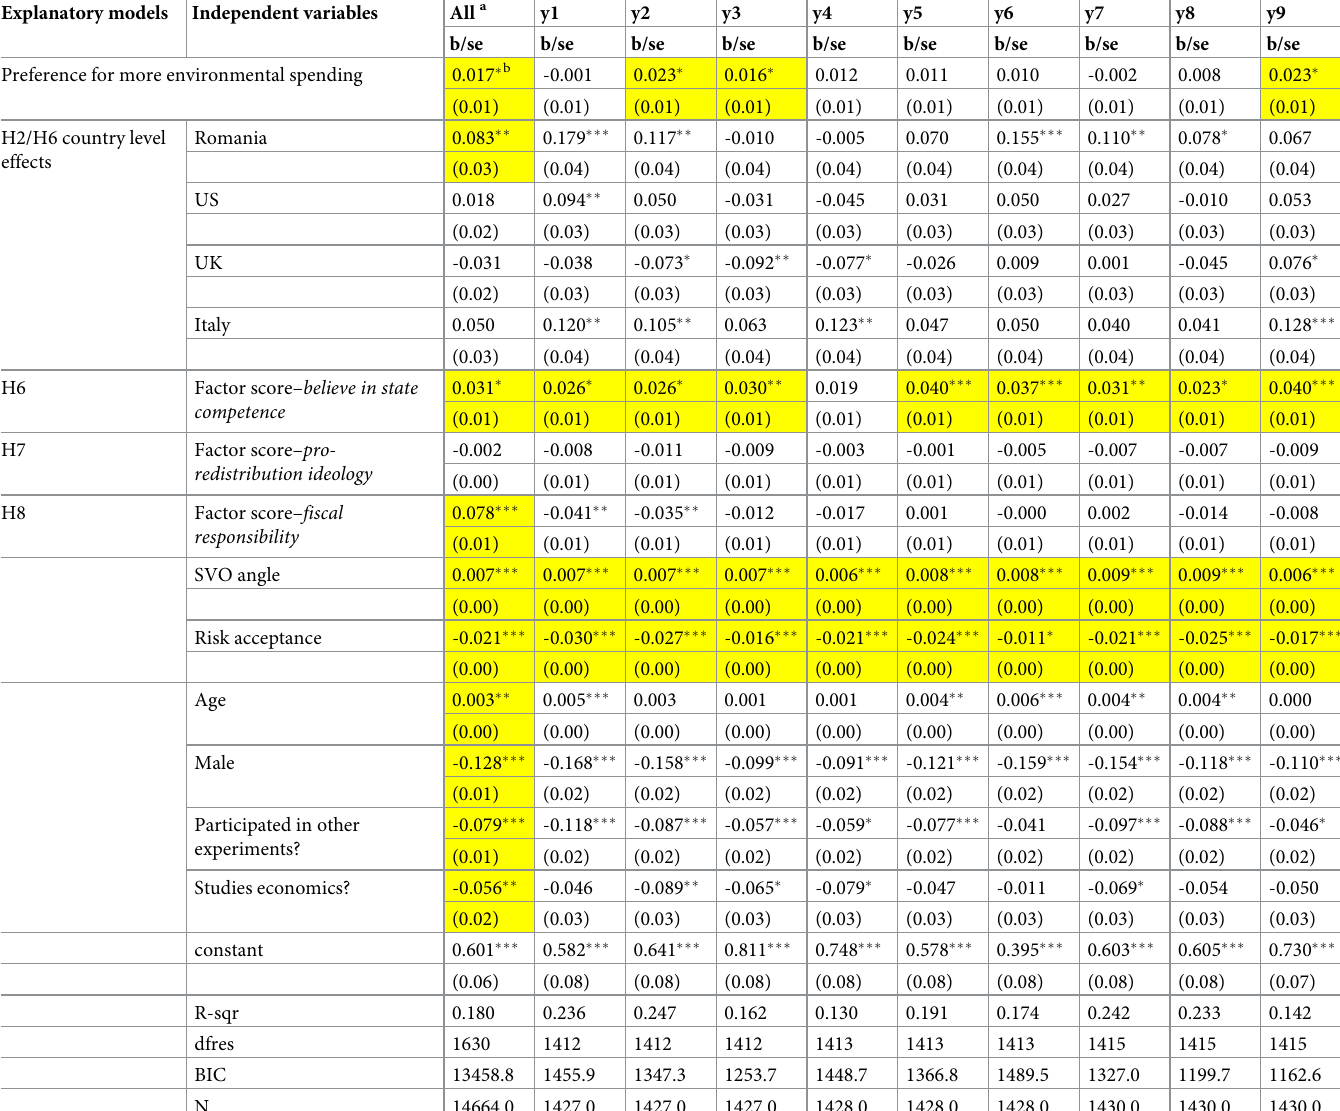
Table 2. Explanatory models for the tax compliance for all scenarios and each separate